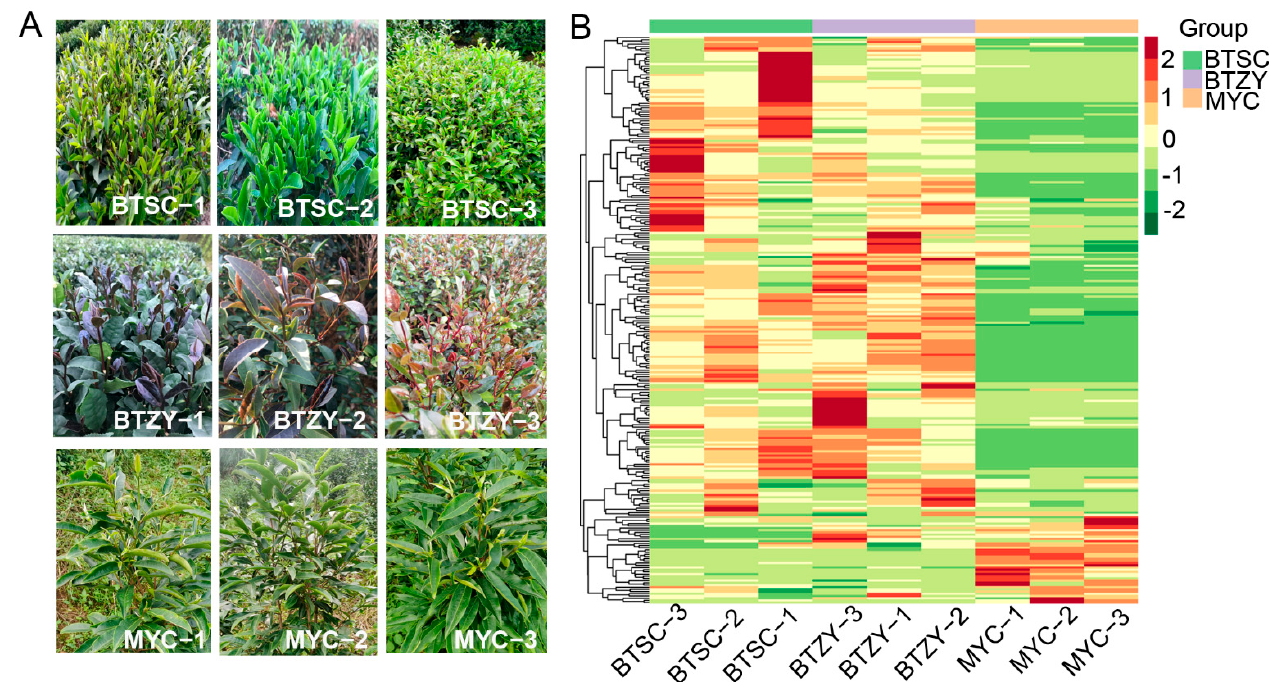
Figure 1. The morphological phenotypes and cluster analysis based on the metabolic profile. ( A ) the typical morphological phenotype of tea plants used in this study; ( B ) the cluster analysis of 259 metabolites based on the metabolome data.